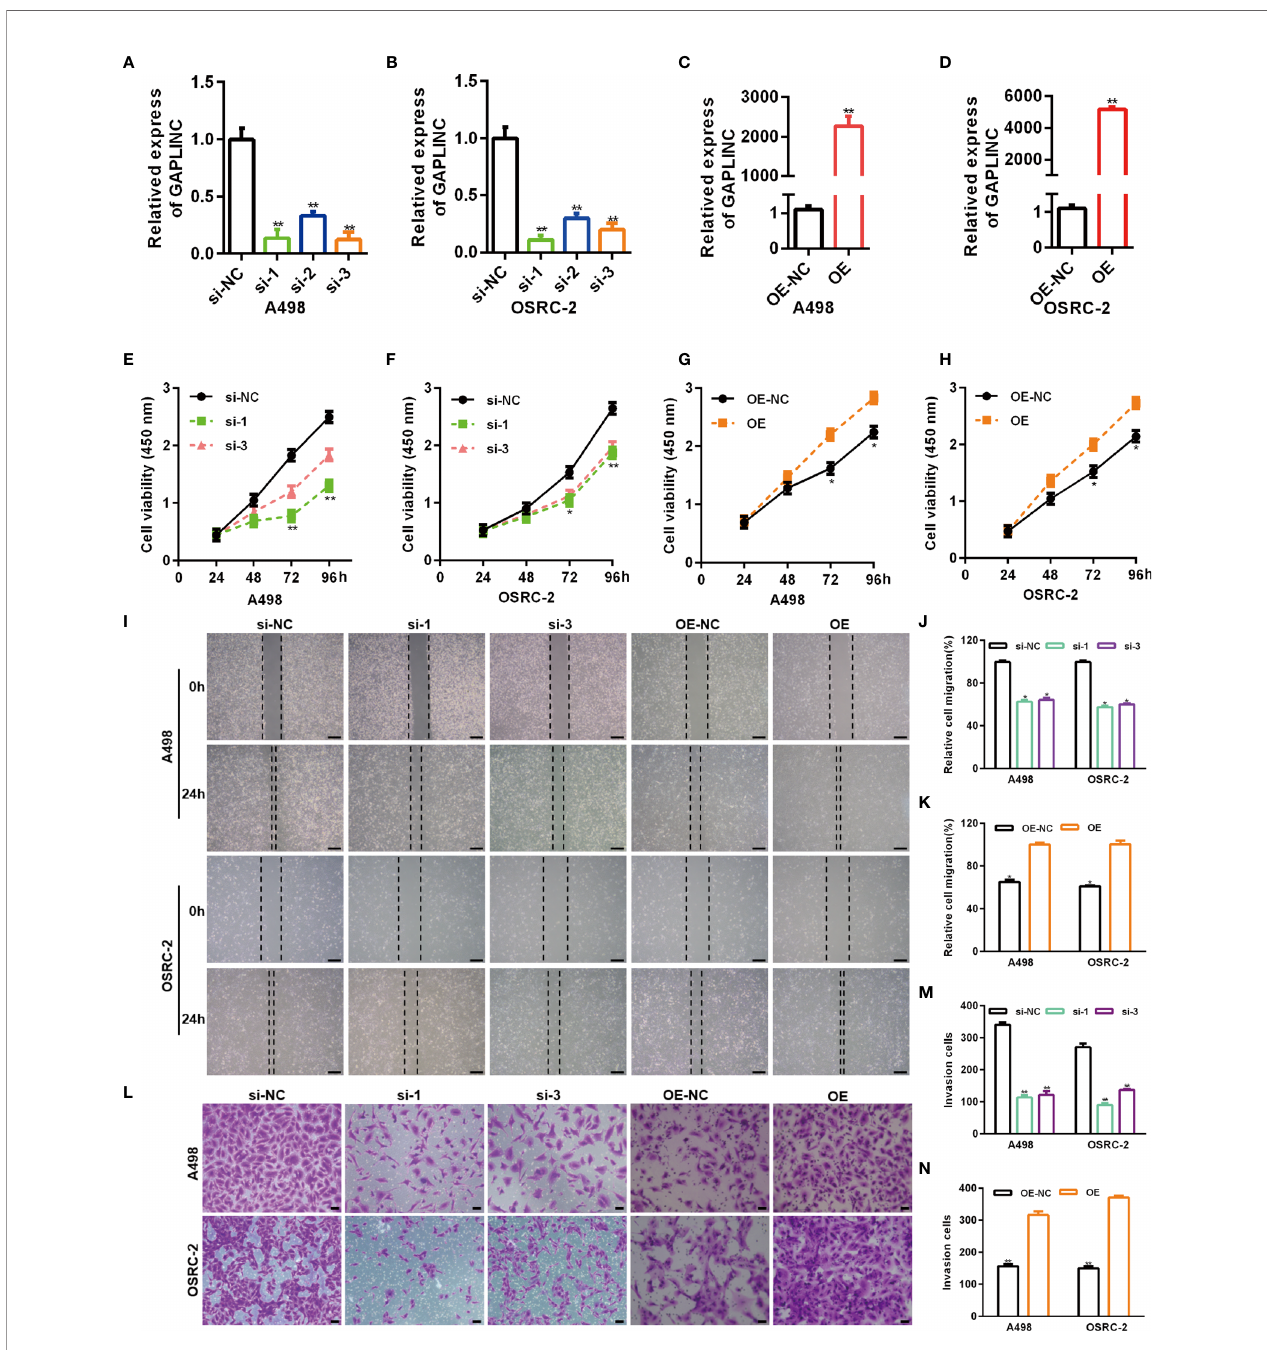
FIGURE 2 | GAPLINC promotes RCC cell proliferation and migration in vitro . Validation of the GAPLINC knockdown (A, B) and overexpression (C, D) ef fi cacy in RCC cell lines by RT-qPCR. (E – H) CCK-8 assays in A498 and OSRC-2 cells with silenced or overexpressed GAPLINC. (I – K) Wound healing assay of cells after silencing or overexpressing GAPLINC expression. Scale bars, 200 m m. (L – N) Transwell migration assays were performed to detect the migration ability when GAPLINC was knocked down or overexpressed. Scale bars, 50 m m. *p < 0.05; **p <